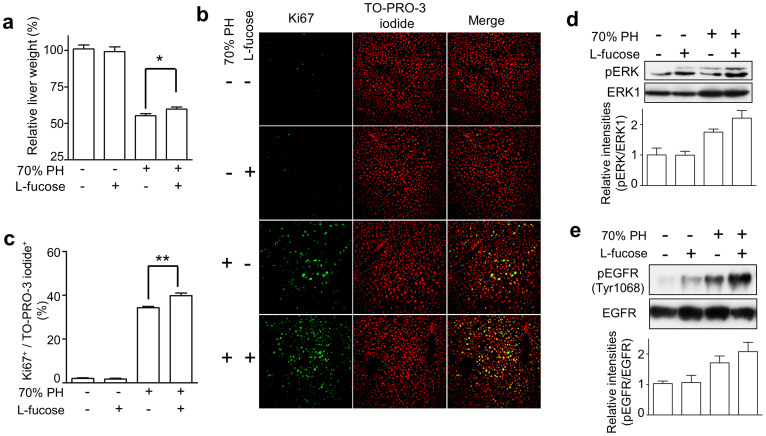
L-fucose supplementation attenuated the decreased regeneration of Fut8+/− mice.(a) Relative liver weight (liver vs whole body) at 2-day after PH in Fut8+/− mice with or without administration of L-fucose. Prior to operation, 6-week old Fut8+/− mice were administrated with L-fucose at 4 g/L in water for 12 days, and then the livers were harvested at 48 hours after PH. The sham group without L-fucose treatment was set as 100%. *, P < 0.05, compared with the mice without L-fucose treatment (n > 10 mice). (b) Immunostaining for liver tissues using anti-Ki67 antibody (200 × field). (c) The quantitative data were obtained from at least 3 mice in each group, *, P < 0.05. Equal protein of liver lysates at day 2 after PH were separated by SDS-PAGE (10% for pERK/ERK1, 7% for pEGFR/EGFR) and blotted with anti-phospho-ERK and anti-ERK1 antibodies. The quantitative data were obtained from 3 mice in each group.